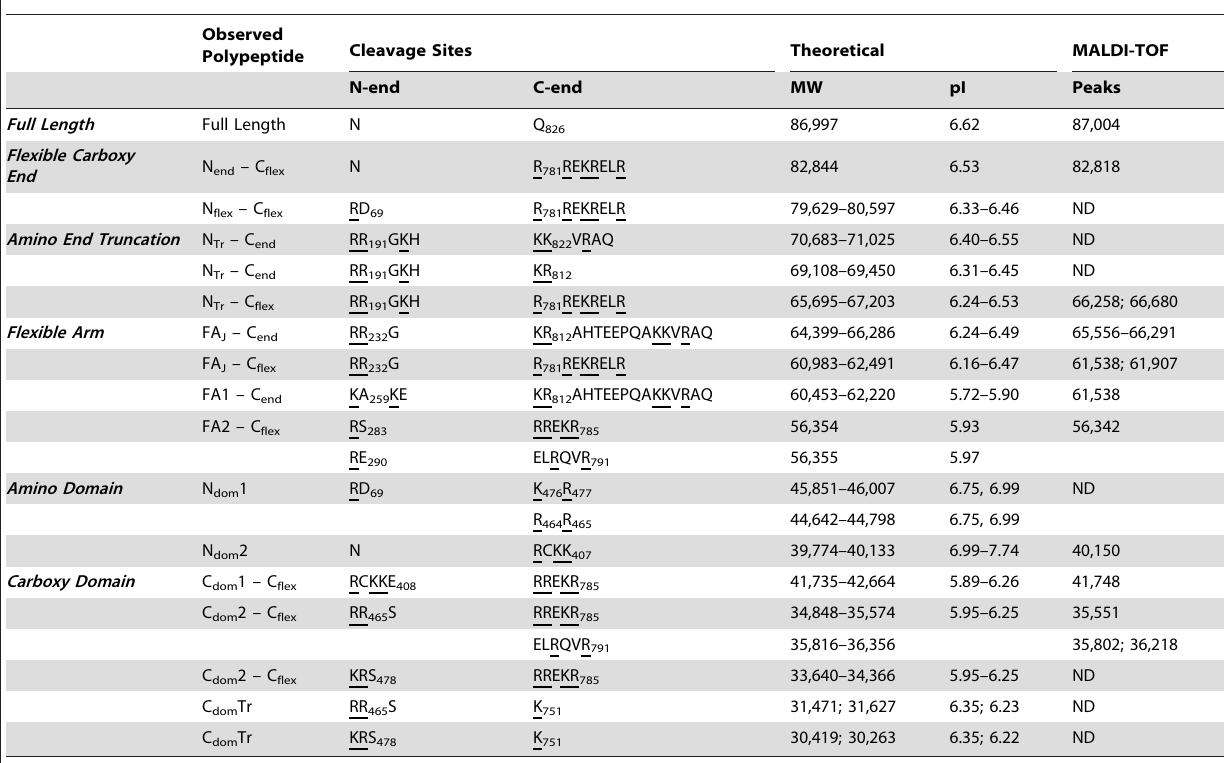
Table 3. H. sapiens tRNase Z L – Trypsin Polypeptides.